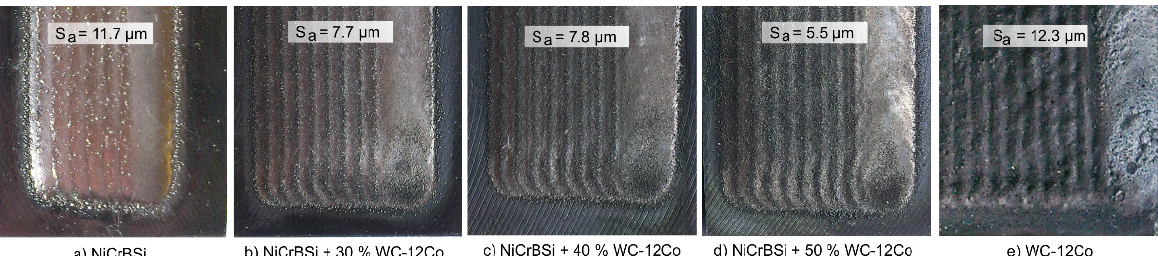
Figure 4. Surface roughness after laser cladding.